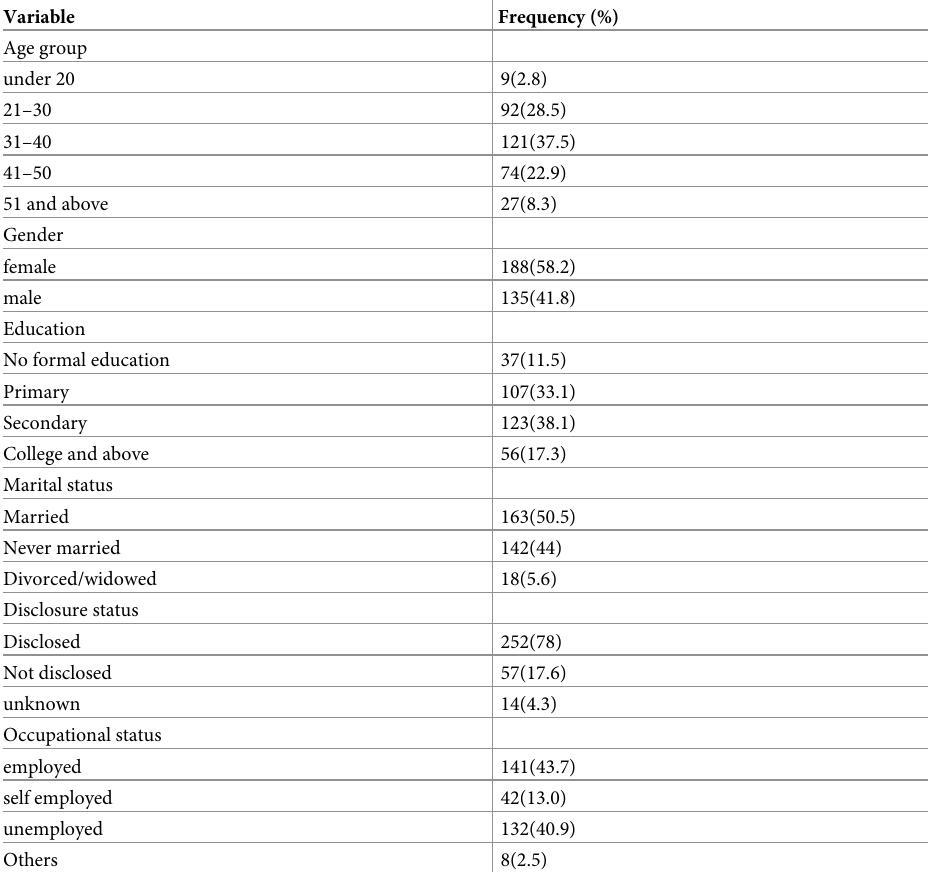
Table 1. Base line Socio-demographic characteristics of first line ART clients in St. Paul’s hospital millennium medical college in Addis Ababa, Ethiopia from July 2016 to December 2020 (N =